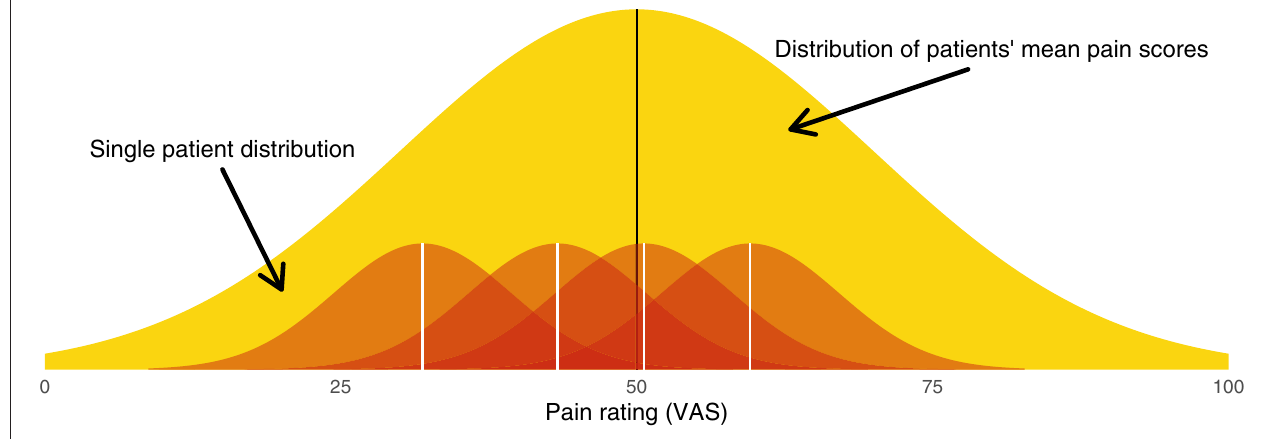
FIGURE 1 | Graphical illustration of the hierarchical model from which patients’ pain scores are sampled. The broad yellow (light gray) distribution is the between-patient distribution (level 2), from which each patient’s mean pain score is sampled. Each red (dark gray) distribution is a within-patient distribution (level 1), from which single measurements are